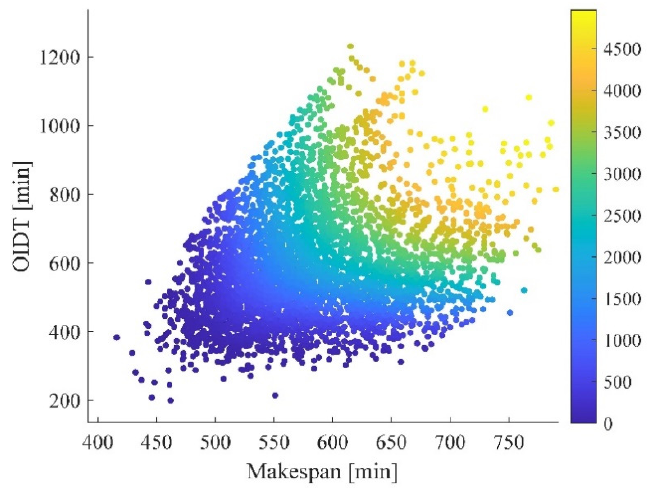
Figure 11. The fitness of the solutions generated during one runtime of NSGA-II for BMP V. The color gradient shows the order of the ranks.